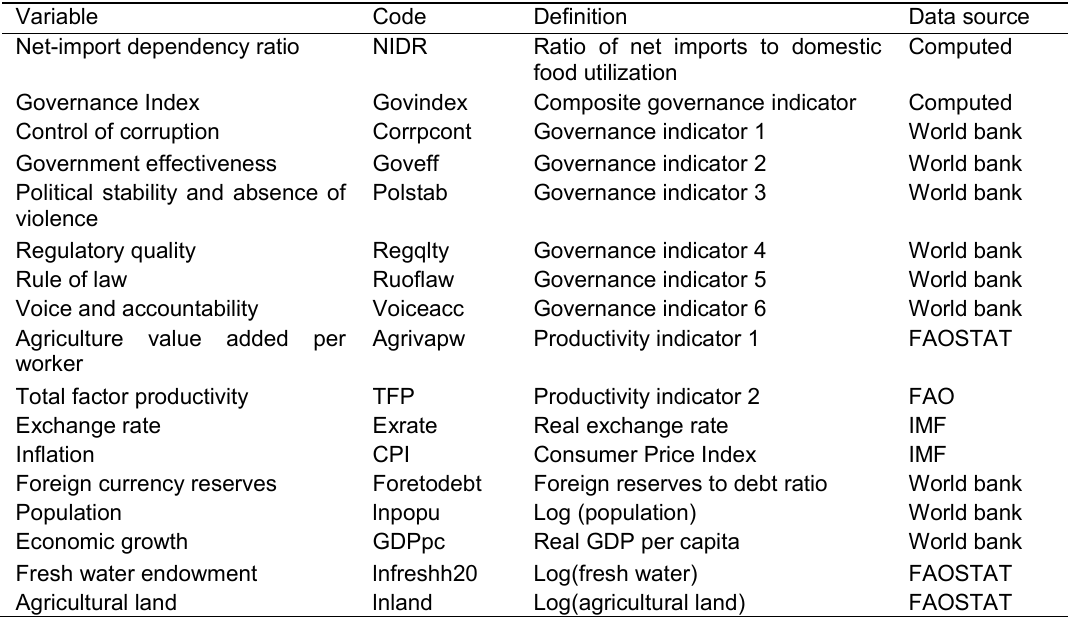
Table 1. Variable description and data